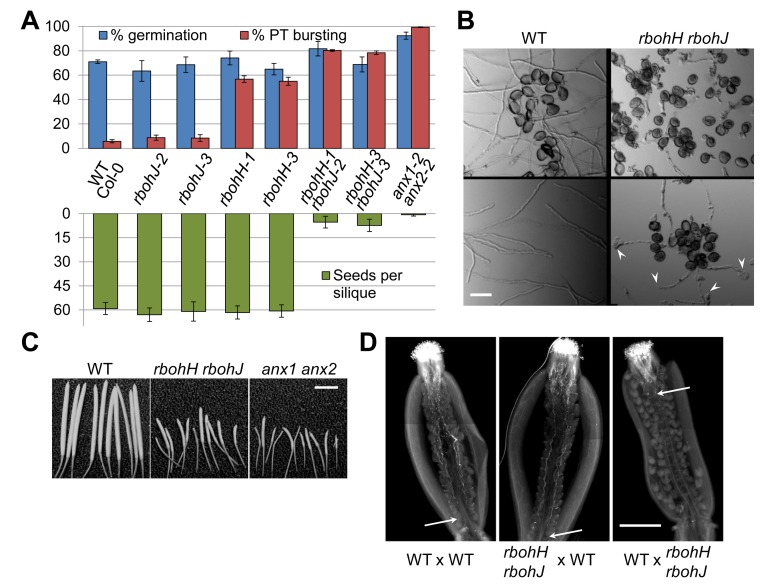

rbohH rbohJ mutant pollen display anxur-like phenotypes.(A) Quantification of pollen germination and PT rupture percentages (top histogram) and seed per siliques (bottom histogram) for WT, single, and double rboh as well as anx1 anx2 mutant plants. Data are mean ± standard error of the mean (SEM) of three independent experiments with more than 150 pollen grains or ten siliques per genotype and experiment. (B) Representative overview images of WT and rbohH rbohJ pollen grown in vitro for 5 h. Up to 80% of germinated pollen from rbohH rbohJ ruptured with clear traces of cytoplasmic content that was released into the medium (top right), while the remaining germinated grains produce PTs that will burst later on (bottom right, arrowheads) as opposed to WT PTs that grow normally (bottom left). Scale bar = 50 µm. (C) Photographs of siliques from WT, rbohH rbohJ, and anx1 anx2 plants. Scale bar = 500 µm. (D) Representative images of aniline blue staining of a WT pistil pollinated with WT pollen (left), a rbohH rbohJ pistil with WT pollen (middle), and a WT pistil with rbohH rbohJ pollen (right). Eighteen hours after manual pollination, WT PTs (left and middle panels) had grown through the entire pistil to reach the female gametophytes. In contrast, most of the rbohH rbohJ mutant PTs (right) were arrested in the transmitting tract. White arrows indicate the tip of the longest PT. Scale bar = 5 mm.